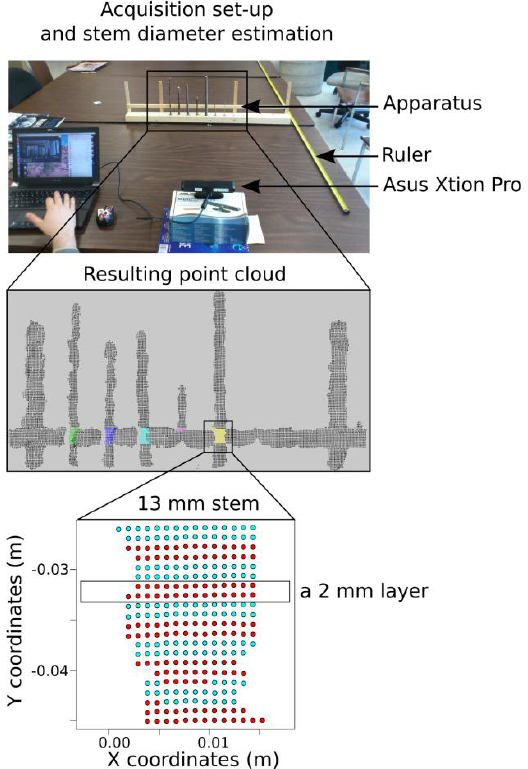
Figure 1. Illustration of the experimental method for quantifying the threshold for diameter detection and the change in accuracy of diameter measurement with distance from static acquisitions with a 3D